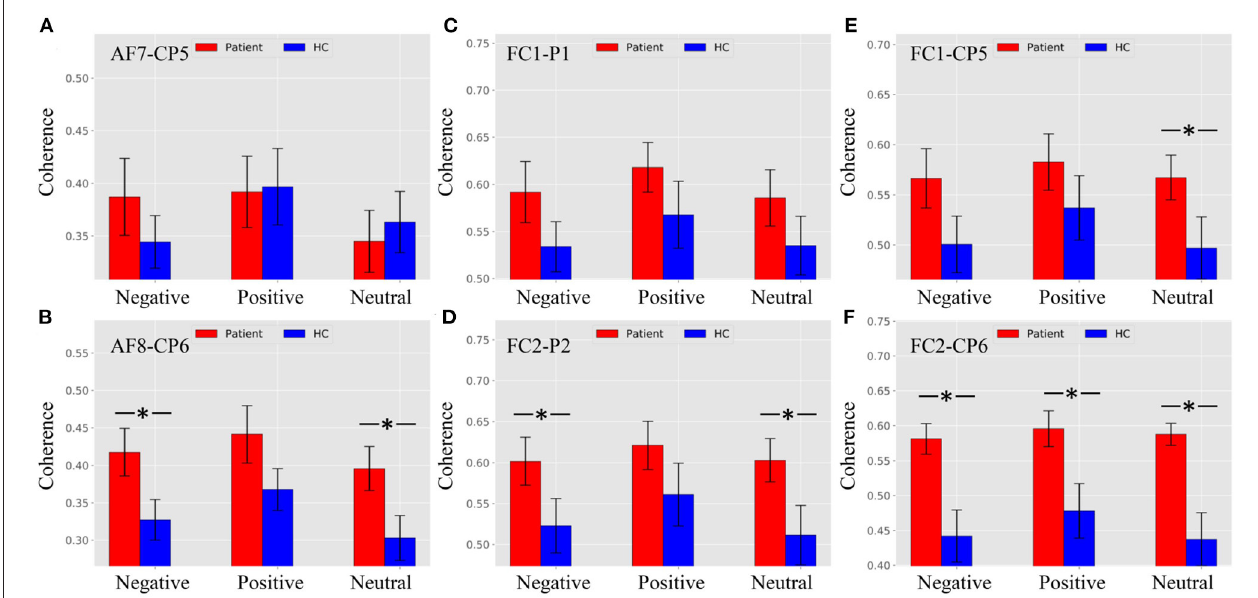
FIGURE 6 | Theta ERPCoh between the frontal and parietal regions in patients and healthy controls (HCs) under different emotional stimuli in ROI (the time window ofnP200, theta band). (A) Theta ERPCoh between patients and HCs for all stimulus trials at the AF796CP5 electrode pair. (B) Theta ERPCoh between patients and HCs for all stimulus trials at the AF896CP6 electrode pair. (C) Theta ERPCoh between patients and HCs for all stimulus trials at the FC196P1 electrode pair. (D) Theta ERPCoh between patients and HCs for all stimulus trials at the FC296P2 electrode pair. (E) Theta ERPCoh between patients and HCs for all stimulus trials at the FC196CP5 electrode pair. (F) Theta ERPCoh between patients and HCs for all stimulus trials at the FC296CP6 electrode pair. * p FDR − corrected ≤ 0.0454.